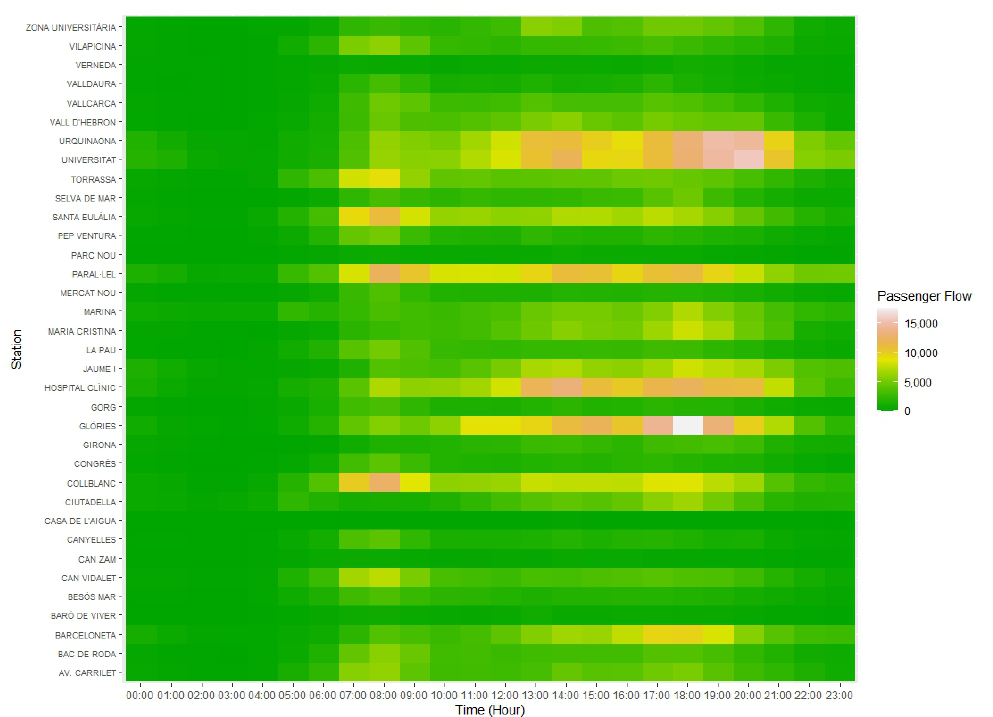
Figure 4. Heatmap with the total number of validations per hour for 35 randomly selected